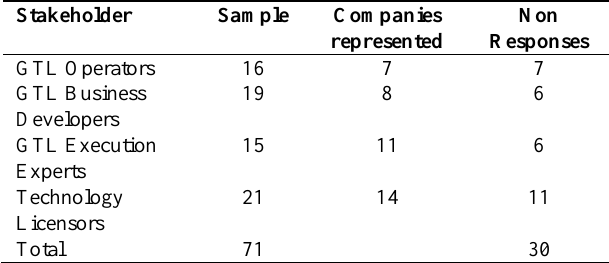
Table 3: Overview of the survey